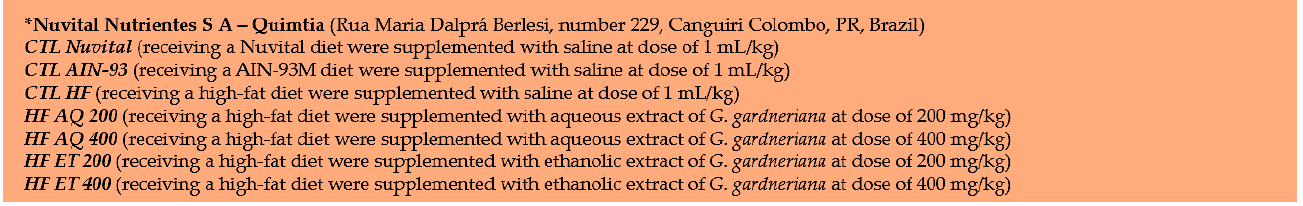
Figure 1. Experimental model design using a high-fat diet.